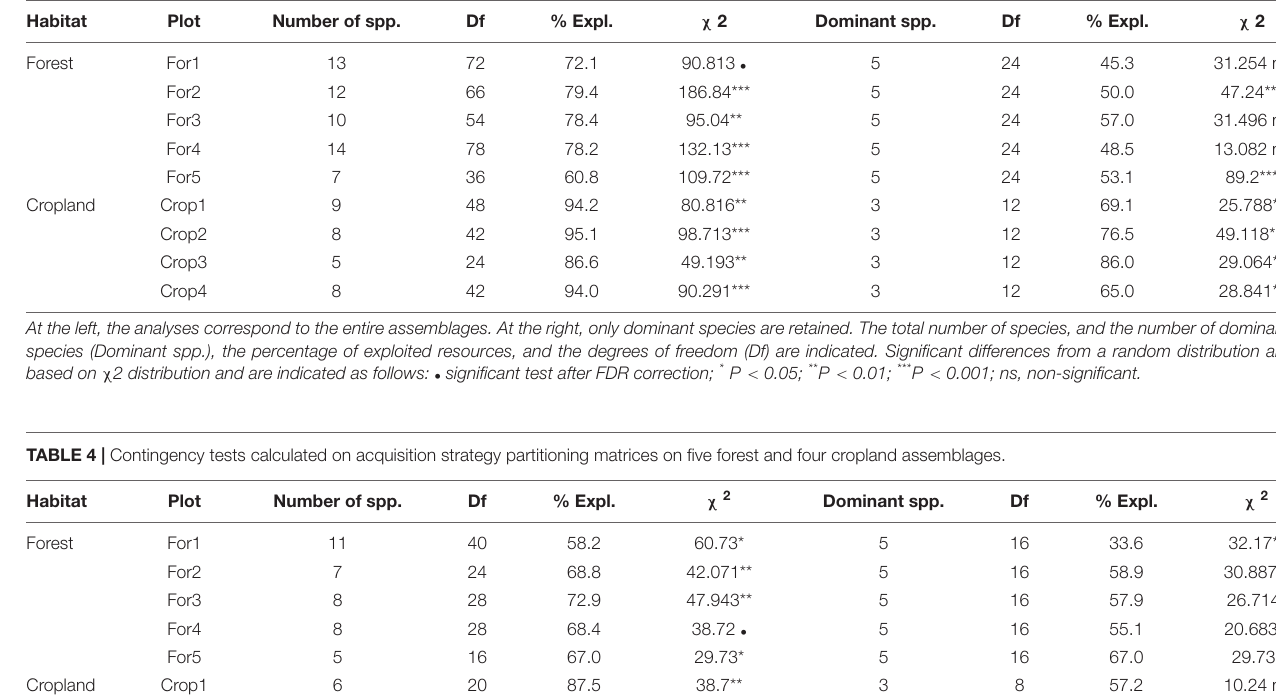
TABLE 2 | Contingency tests calculated on resource use matrices by dominant species. Habitat